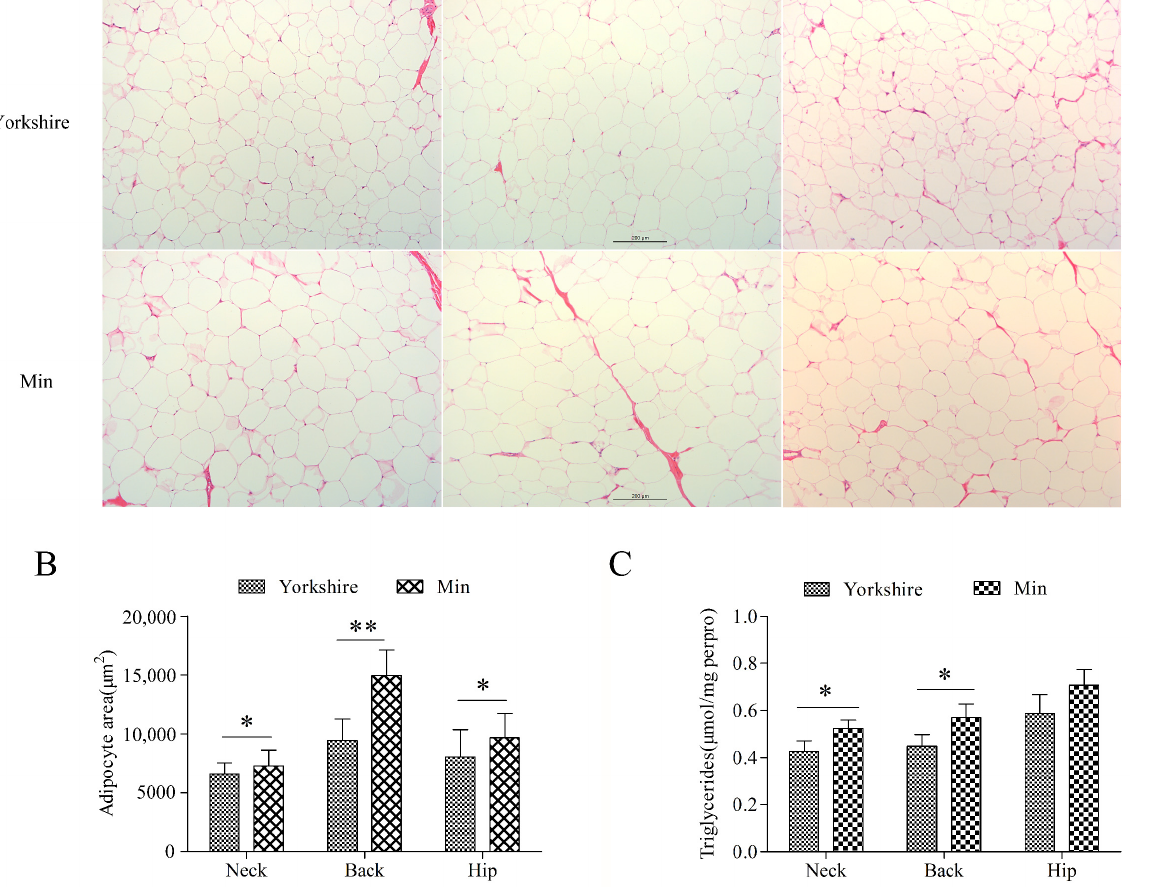
Figure 1. Comparison of subcutaneous adipose tissues between Yorkshire and Min pigs. ( A ) Mor- phological analysis with HE staining. ( B ) Adipocyte area of subcutaneous adipose tissues. The bar is 200 µ m. ( C ) Triglyceride contents in subcutaneous adipose tissues. The data are shown as mean ± standard error. * and ** indicate p < 0.05, and p < 0.01,